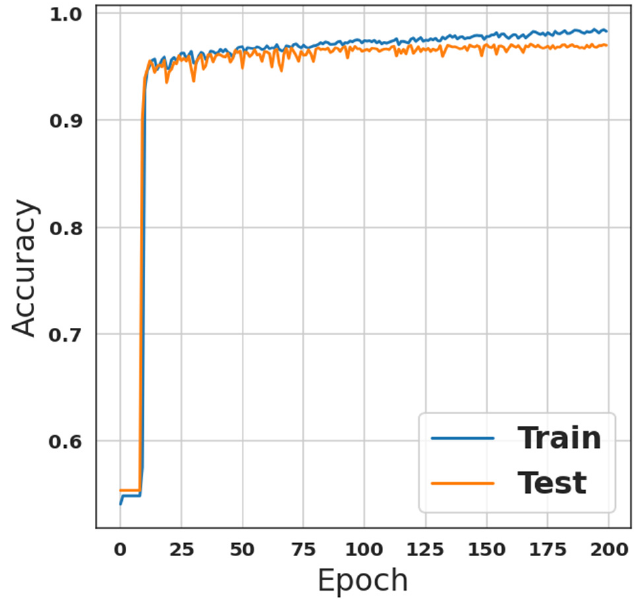
Figure 1. Accuracy of the first model, as shown in Table 1, results.